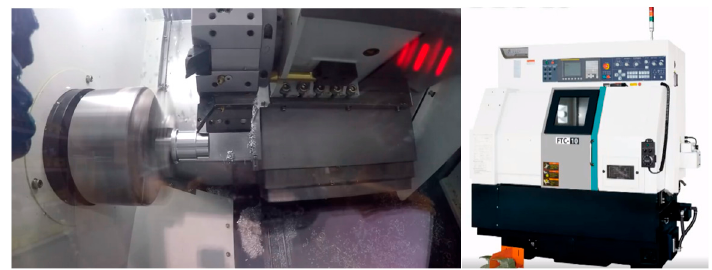
Figure 2. Feeler turning machine (Model: FTC-10) used in experiments. Table 3. Specifications of workpiece and cutting tool.